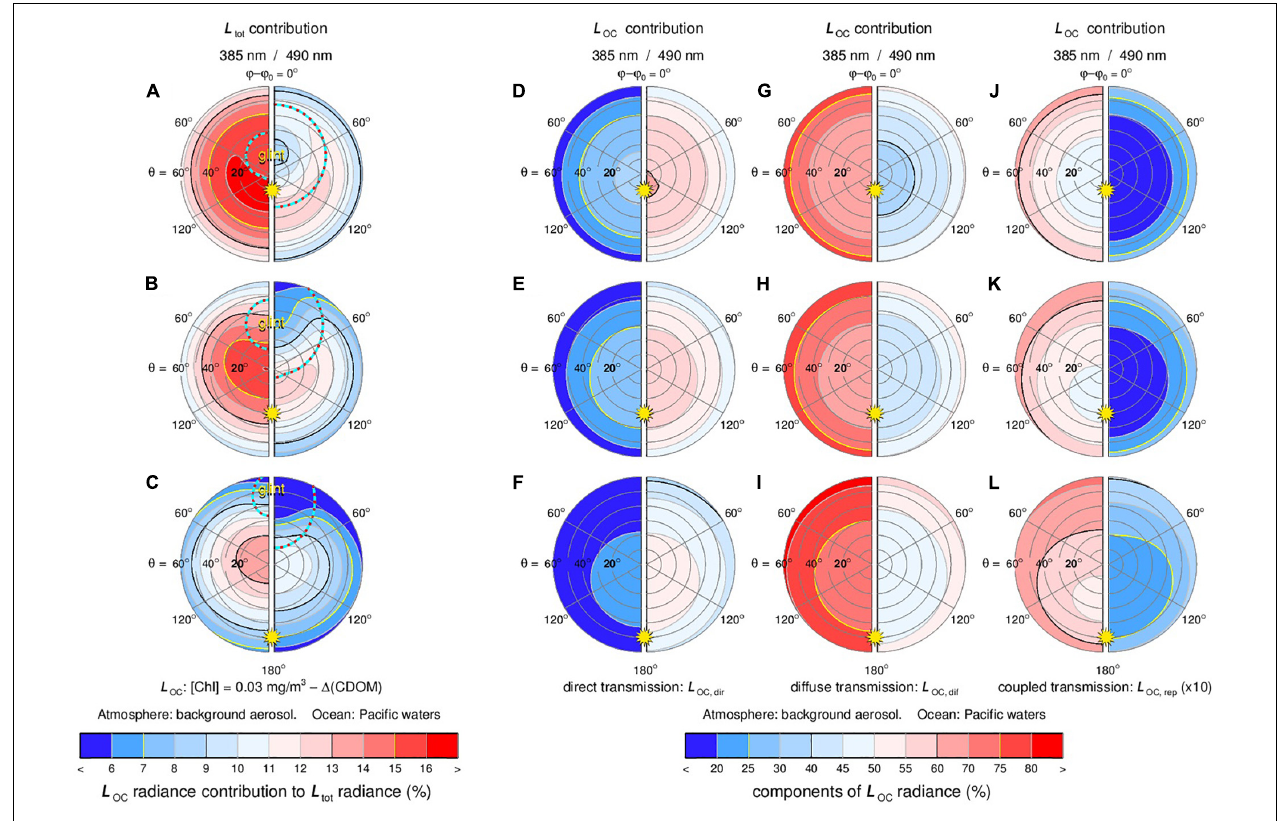
FIGURE 16 | Radiative transfer simulations of radiance contributions to TOA observations. First column shows underwater light scattering radiance ( L OC ) contribution to TOA radiance ( L tot ). Left and right hemispheres are for 385 and 490 nm, respectively. The sun (denoted by a yellow star in the backscattering direction) is located at 10 ◦ (first row), 30 ◦ (second row) and 50 ◦ (third row). Second, third and fourth columns show contributions to radiance ( L OC ) of direct transmitted water-leaving radiance ( L OC , dir ), diffuse transmitted radiance ( L OC , dif ), and coupled water-leaving radiance ( L OC , rep ), respectively.